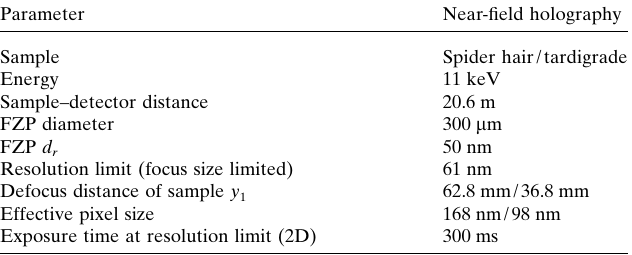
Table 2 Parameters of the near-field holography measurements.